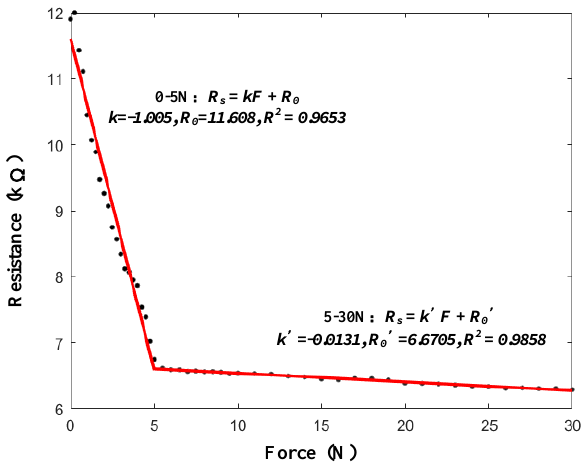
Figure 13. The two sensitivity intervals of the proposed